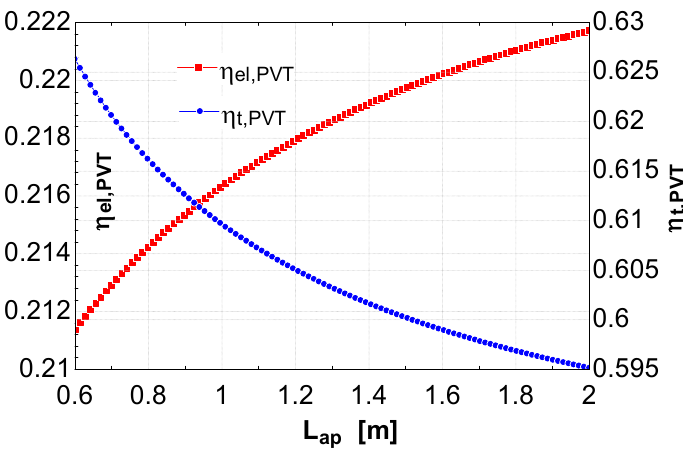
Figure 11. CPVT thermal and electrical efficiency vs. aperture length.